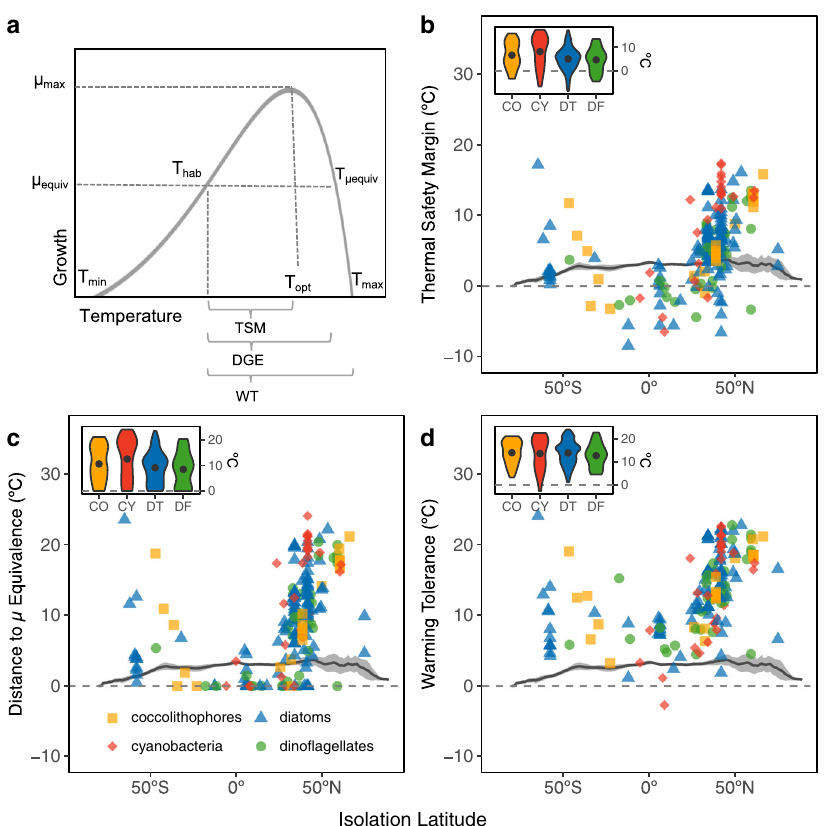
Fig. 3 Thermal capacities for each functional type. Thermal performance metrics ( a ), including thermal safety margin ( b , TSM = T opt − T hab ), distance to the growth equivalence ( c , DGE = T µ equiv − T hab ) and warming tolerance ( d , WT = T max − T hab ) are shown. An isolate existing below zero (dotted line) has already surpassed the given thermal capacity under historical, baseline conditions (1950 – 1970). For example, for the DGE ( c ), values of zero indicate individuals were isolated at temperatures at or above their T opt . Gray solid line characterizes the amount of warming predicted for each latitude by 2100, with the shading representing longitudinal variation (sd). Violin plots within each fi gure ( b – d ) display the mean (points) and density distribution of thermal capacities for each functional group (Coccolithophores = CO, cyanobacteria = CY, diatoms = DT, dino fl agellates = DF). Only strains of known origin with good quality fi t in T max were used in calculations (CO = 24, CY = 31, DT = 115, DF =